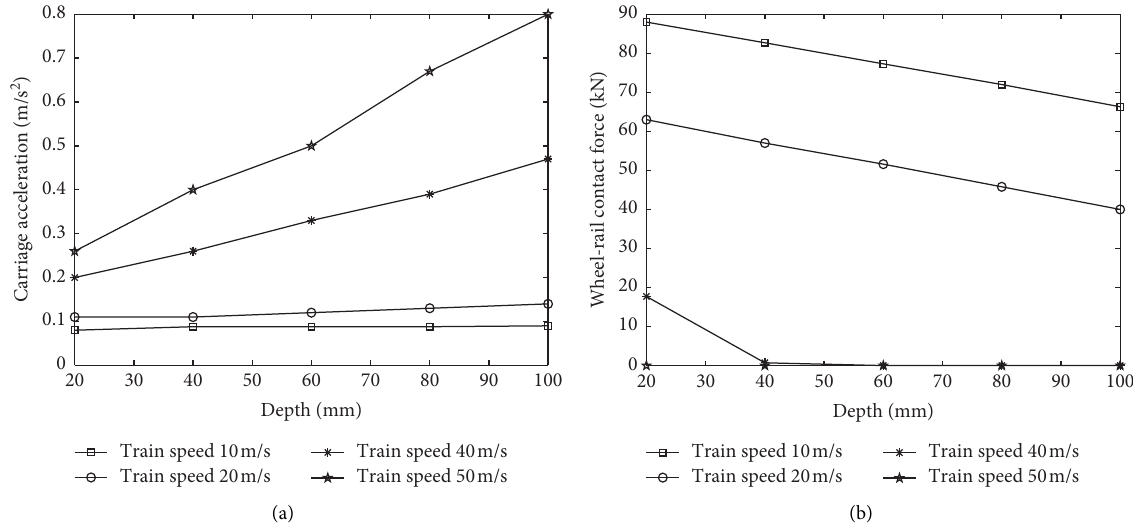
Figure 15: Effects of train speed on metro train-track vibration with tunnel differential settlement (settlement length λ (a) Maximum acceleration of the carriage. (b) Minimum wheel-rail contact